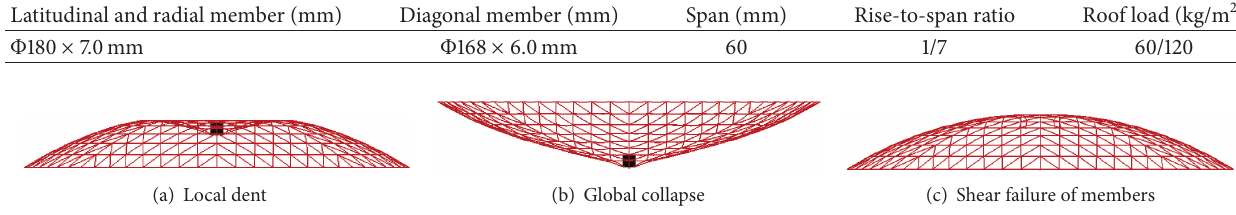
Figure 3: Damage modes of single-layer Kiewitt-8 reticulated dome.